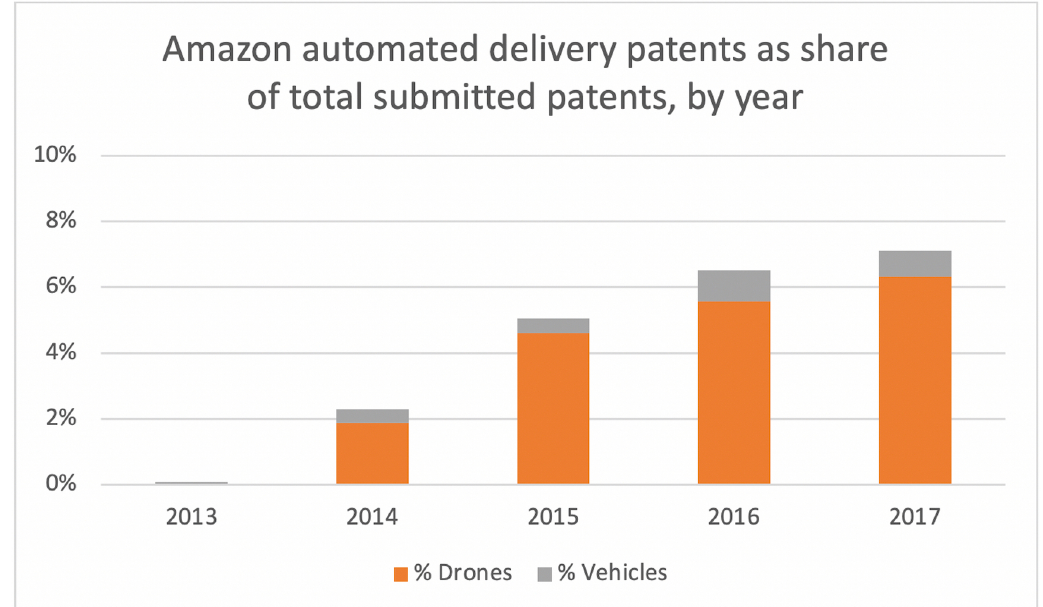
Figure 2: Automated delivery patents as share of total Amazon patents submitted, by